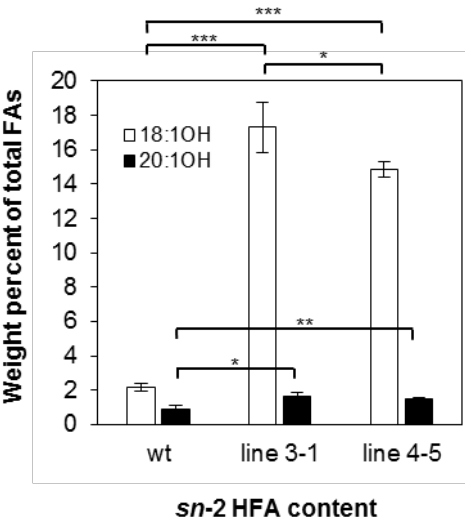
Figure 3. HFA content at the sn -2 position of TAG. Ricinoleic acid (18:1OH, open bars) and lesquerolic acid (20:1OH, black bars) at the sn -2 position of TAG from wild type (wt) and transgenic line 3-1 and line 4-5 are measured in weight percent of total FA. Triplicates of 50-seed sample were measured for wild type and transgenic lines. The data represent averages of three replicates ± SE. Two-tailed Student’s t test. * p < 0.05; ** p < 0.01; *** p < 0.001.